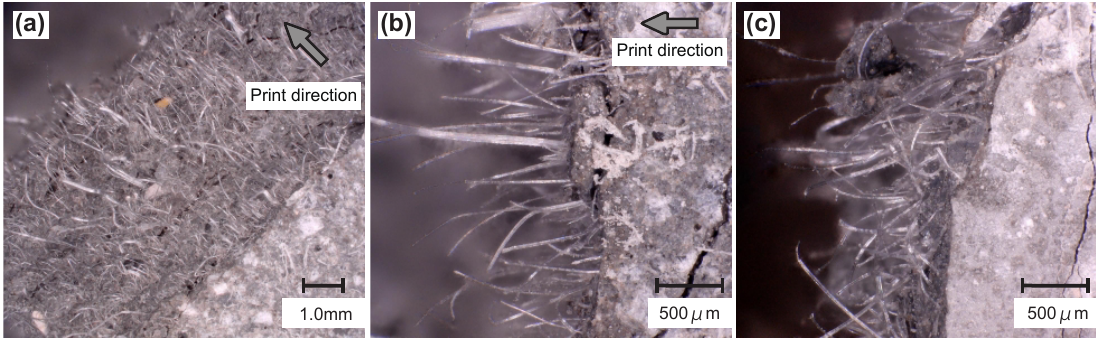
Figure 14. Microscopic images of fracture surfaces of: ( a , b ) C-print specimens; and ( c ) C-cast